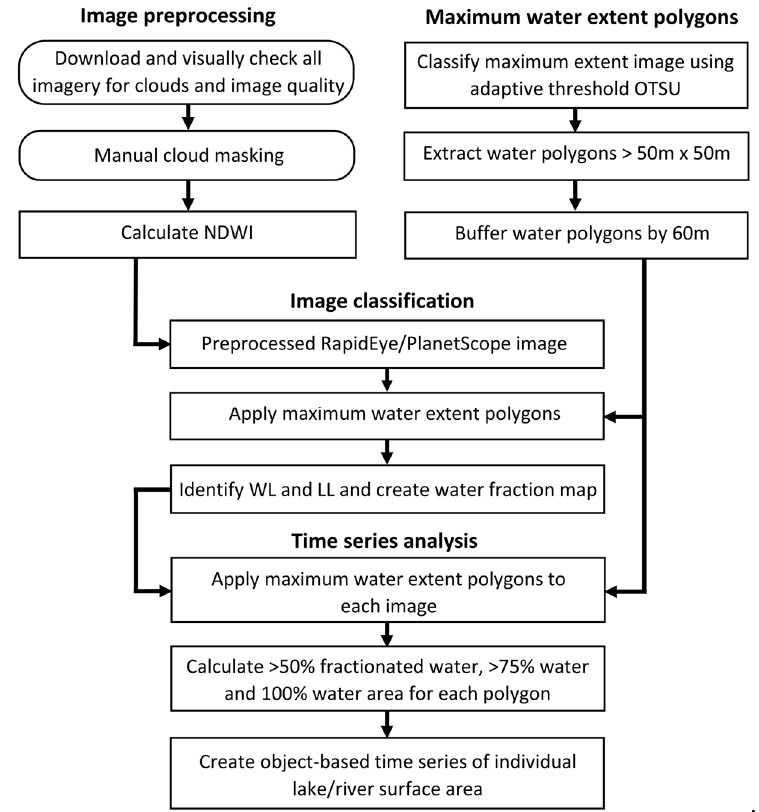
Figure 2. Water fraction classification workflow for Planet imagery. Rounded boxes represent manual steps and rectangles are fully automated steps.